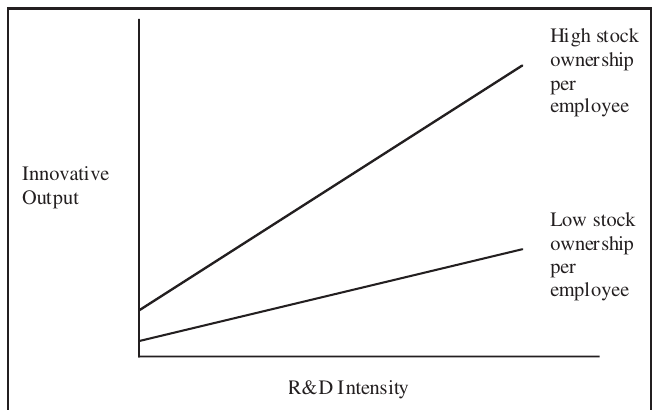
Figure 1. Employee ownership as moderator of the relationship between R&D intensity and